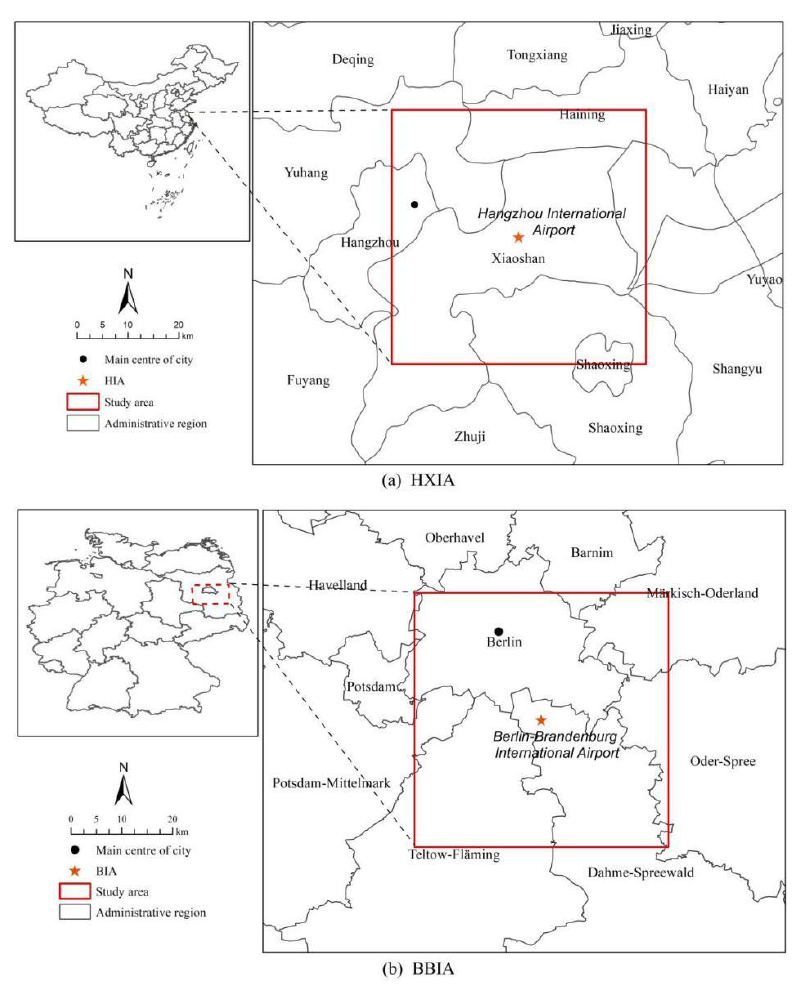
Figure 3. Location and study areas of the two airports: ( a ) HXIA; ( b ) BBIA.